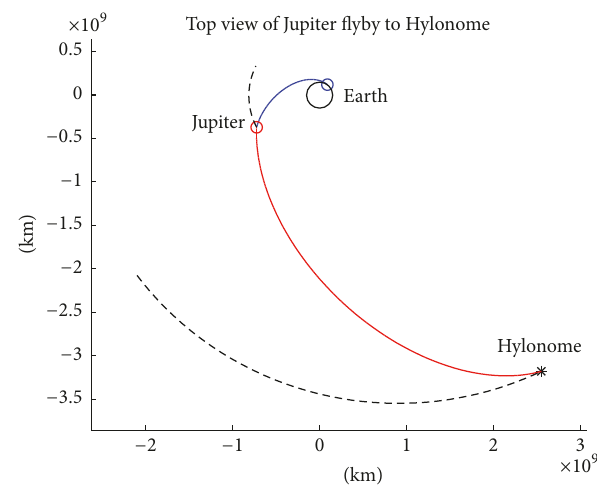
Figure 7: Single flyby trajectory simulation